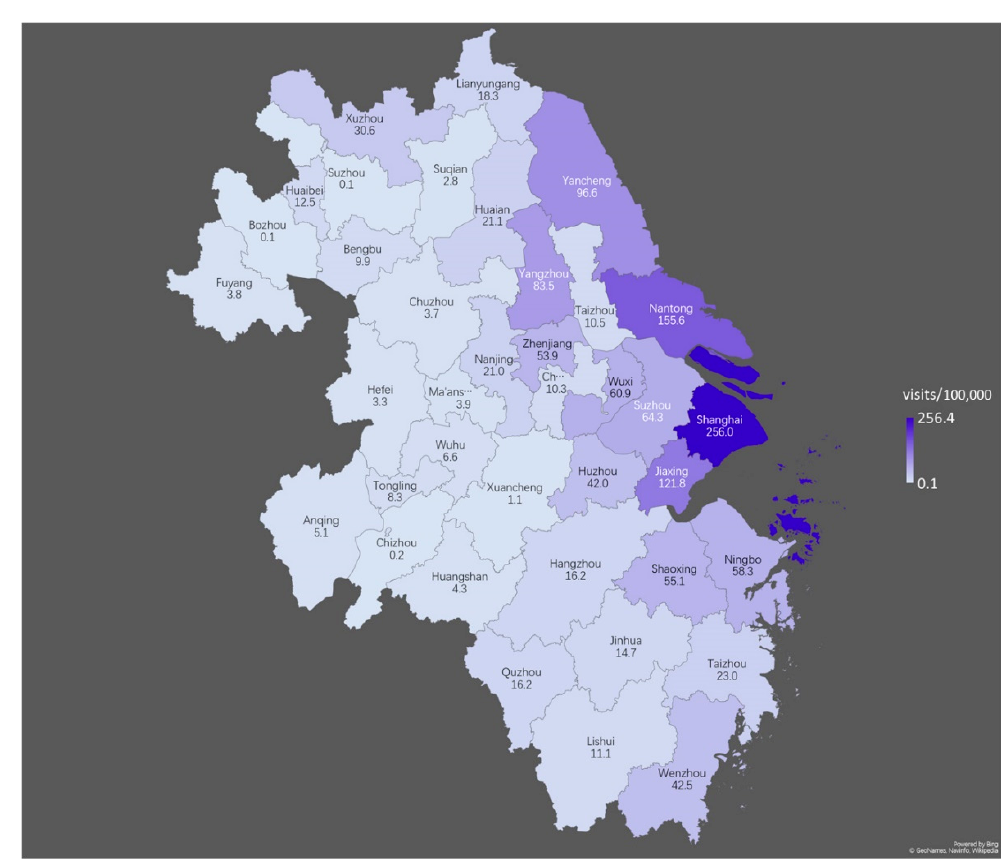
Figure 4. The SOV (visits/100,000) from the 40 cities of Yangtze River Delta to four hospitals in Shanghai (October 2019–September 2020).